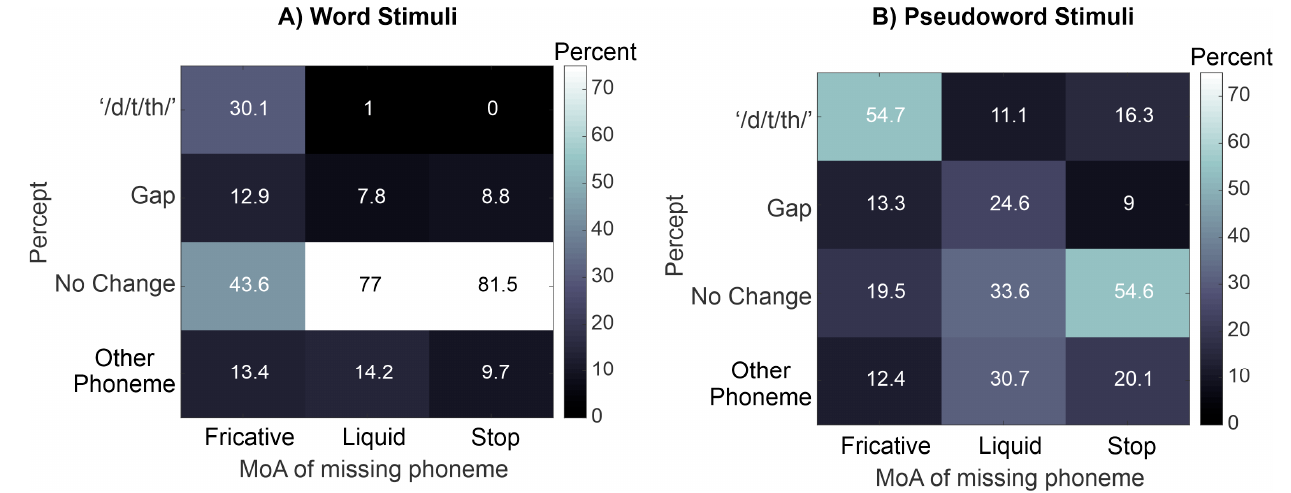
Figure 2. Group-average percentages of each percept reported for the (A) Word and (B) Pseudoword stimuli, depending on the MoA of the missing phoneme. The percentages of each percept were calculated separately within each MoA category (i.e., each column adds up to 100%).